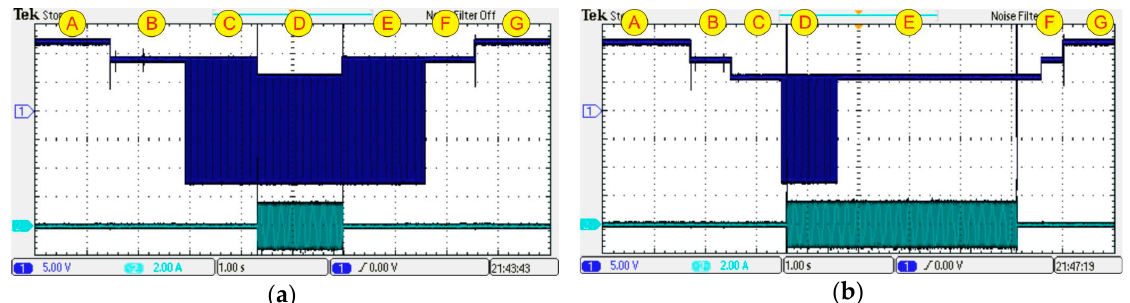
Figure 4. Communication signals between EVSE and EV. Ch 1 – u CP and Ch 2 – i L 1 ( a ) Control from EV; ( b ) Control from EVSE.